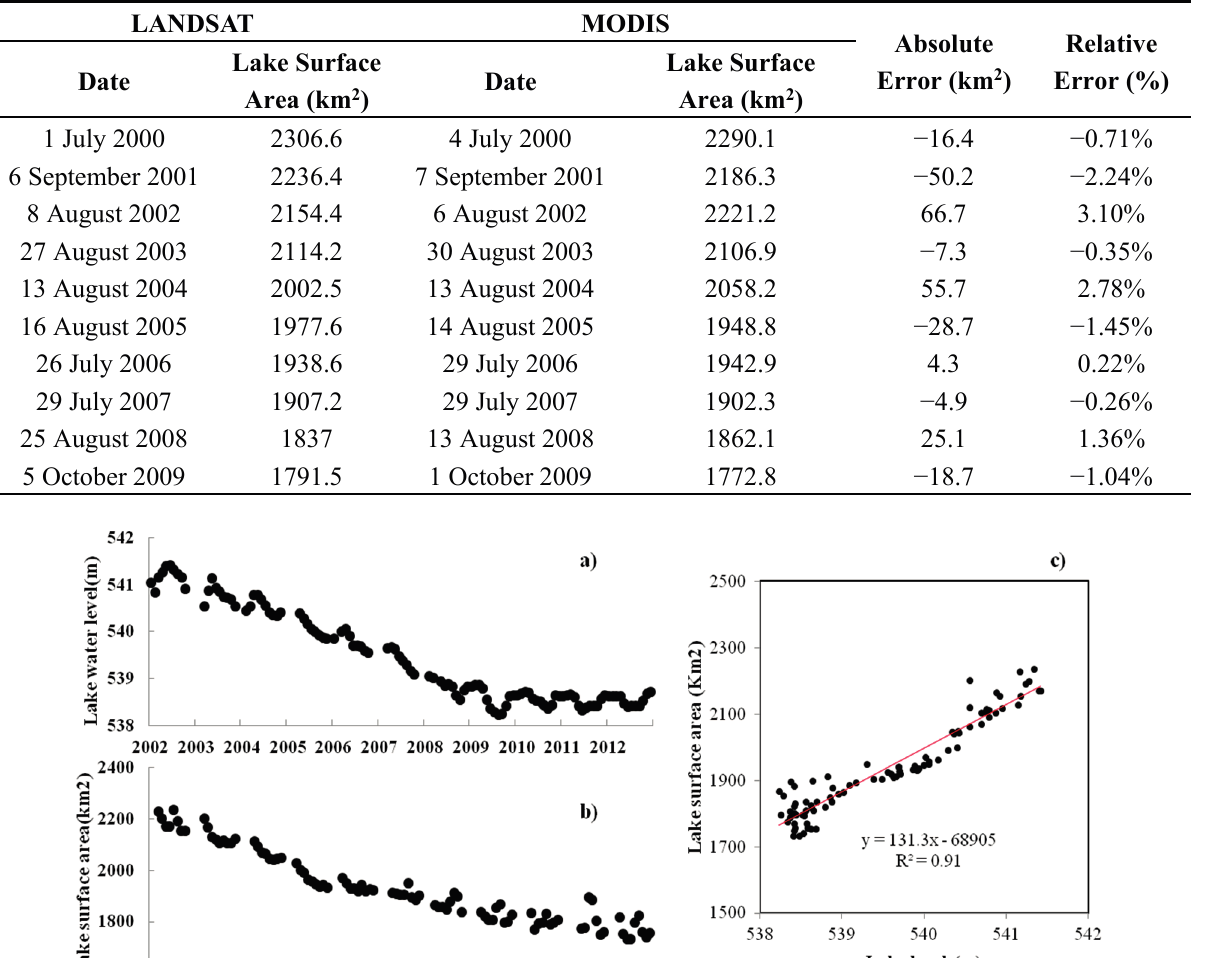
Table 2. Comparison of Moderate Resolution Imaging Spectro-radiometer (MODIS) and LANDSAT derived Hulun lake area.